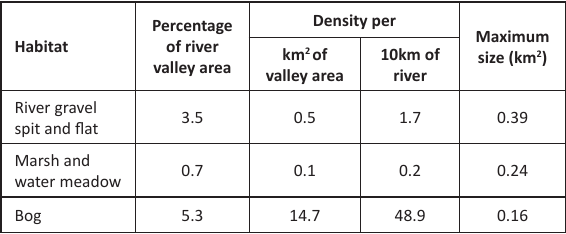
Table 1. Habitats found in the main stream valley of the stopover study